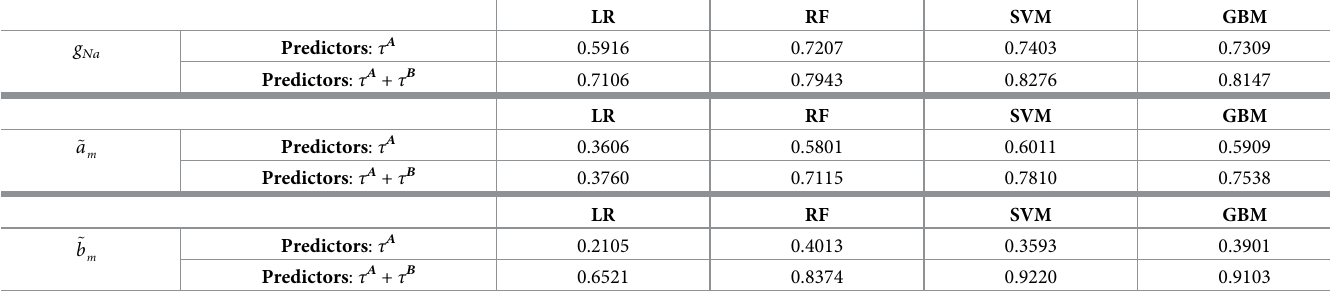
Table 5. R 2 values for LR, RF, SVM and GBM procedures to predict the sodium HH parameters.